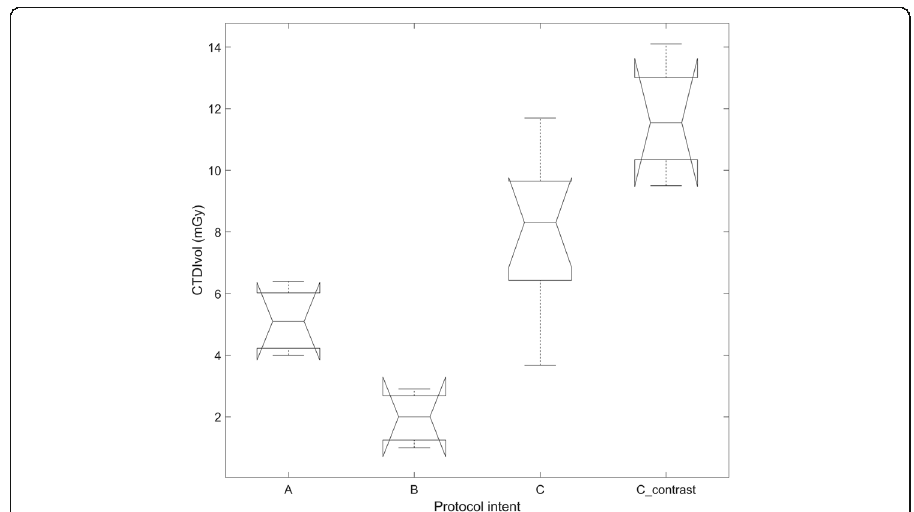
Fig. 2 Distributions of CTDI vol values for each protocol intent. a CT acquisition for anatomic localization and attenuation correction. b CT acquisition for attenuation correction only (ULTRA-low dose). c CT acquisition for diagnostic purposes and attenuation correction without contrast and C_contrast CT acquisition for diagnostic purposes and attenuation correction with contrast. In particular, only protocol intent C included also data about the CTDI vol values of the x-ray contrast medium examinations. The error bars of protocol intent C are wider than the A and B protocols due to their intrinsic diagnostic nature. CTDI vol values for protocol intents A and B were statistically different from protocol intent C ( p = 0.002); in addition, CTDI vol values were statistically different for protocol intents C and C_contrast ( p = 0.009)